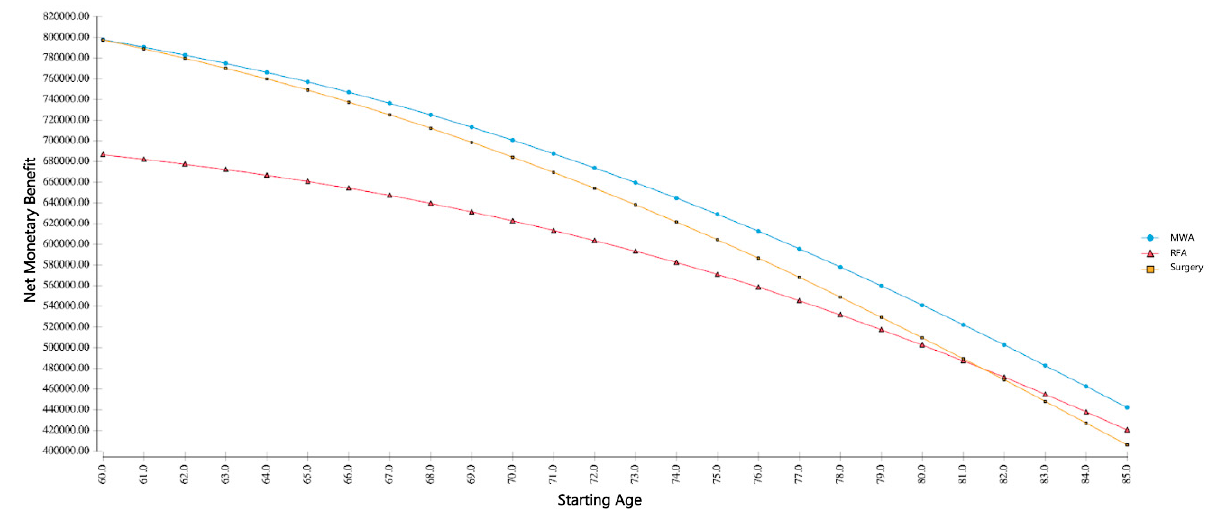
Figure 1. Age-dependent net monetary benefits based on a WTP of USD 100,000 per QALY. For a patient aged under 60 years, surgery yields the highest net monetary benefits; for other patients, microwave ablation results in the highest net monetary benefit.